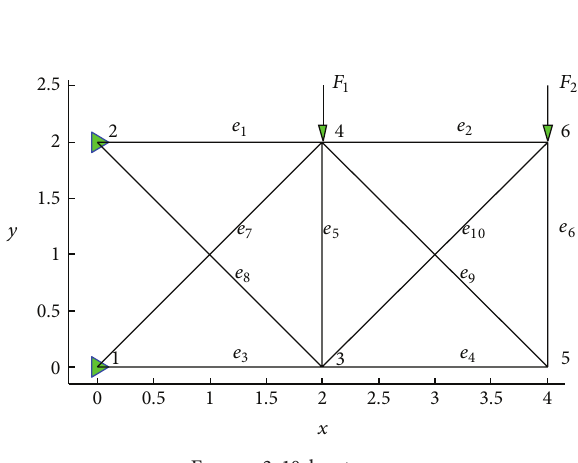
Figure 2: 2-bar truss.